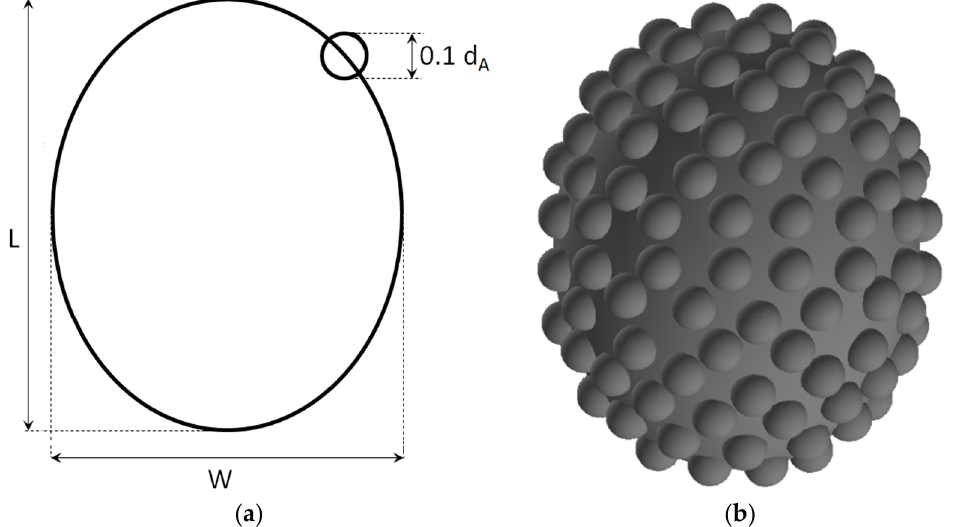
Figure 4. ASC, ( a ) idealization of the shape, ( b ) modelled idealized shape.